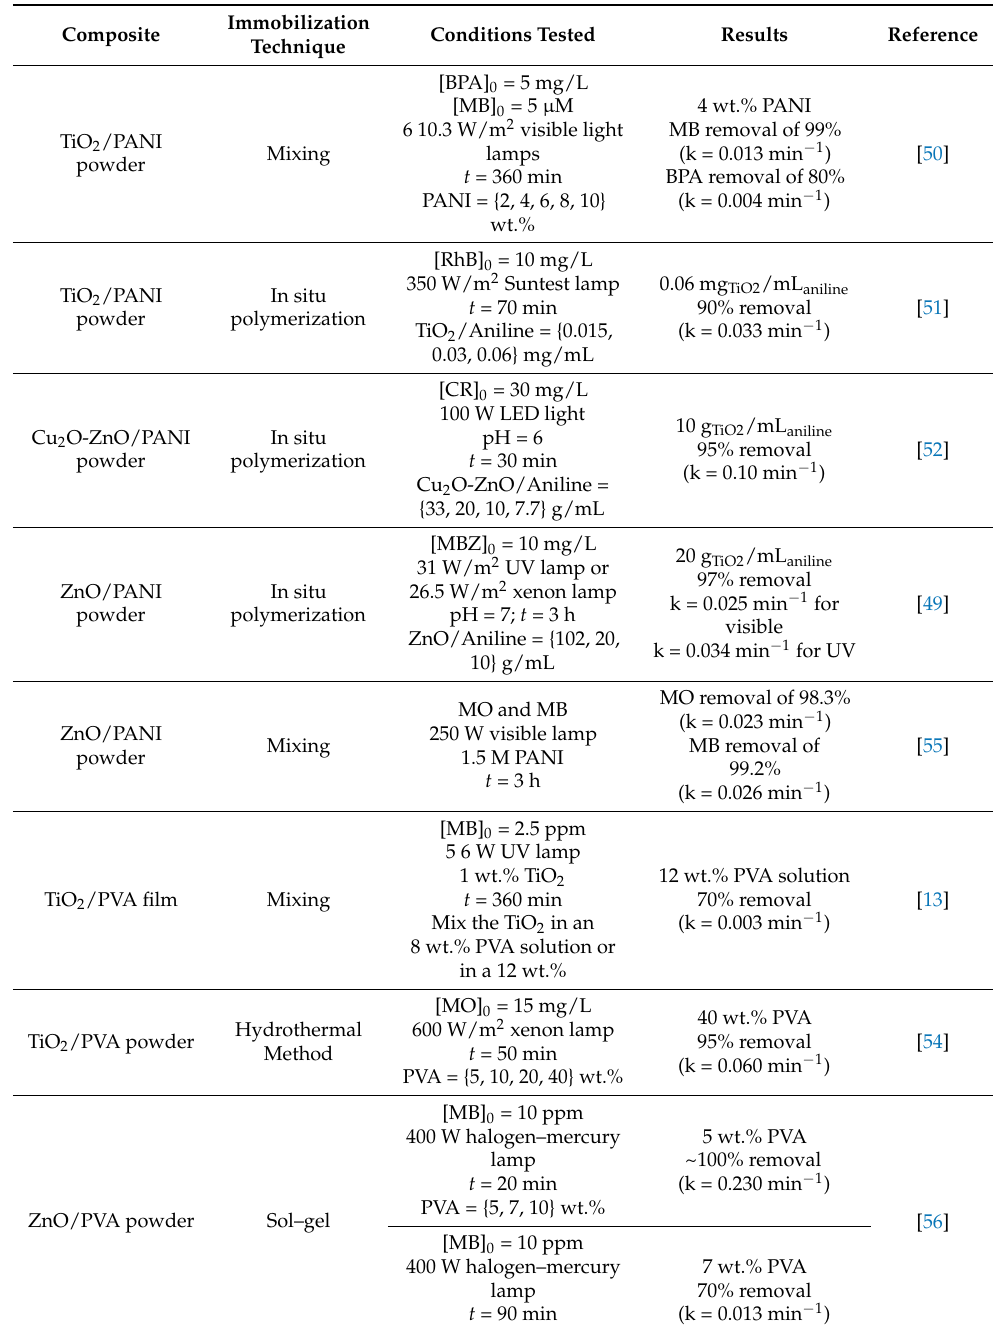
Table 1. Summary of studies that have analyzed the effect of the polymer load on the polymer- supported photocatalysis